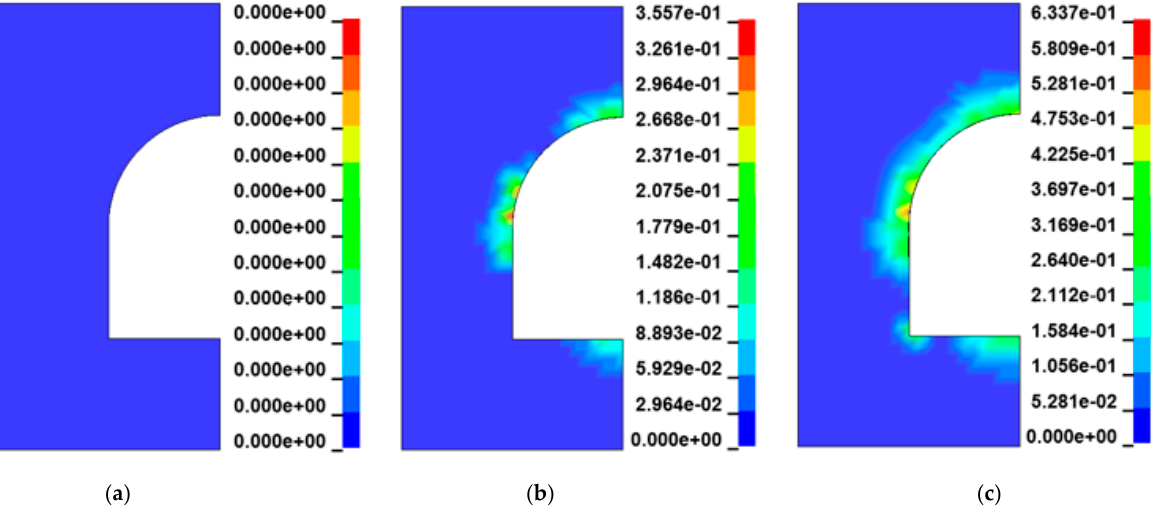
Figure 5. Damage of roadway wall under different explosion loads. ( a ) Explosion energy + 0 ( b ) Explosion energy + 4GJ and ( c ) Explosion energy + 16GJ